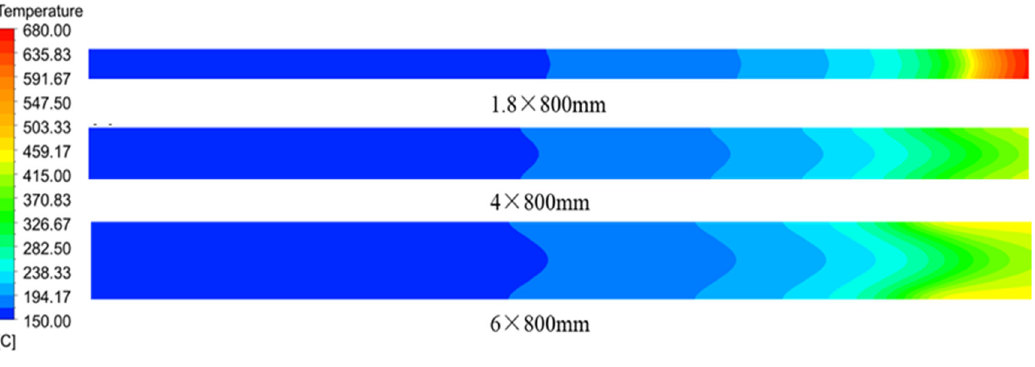
Figure 8. Temperature distribution curve of the central axis under adiabatic conditions. Figure 9. Polymer conversion rate curves under adiabatic conditions.